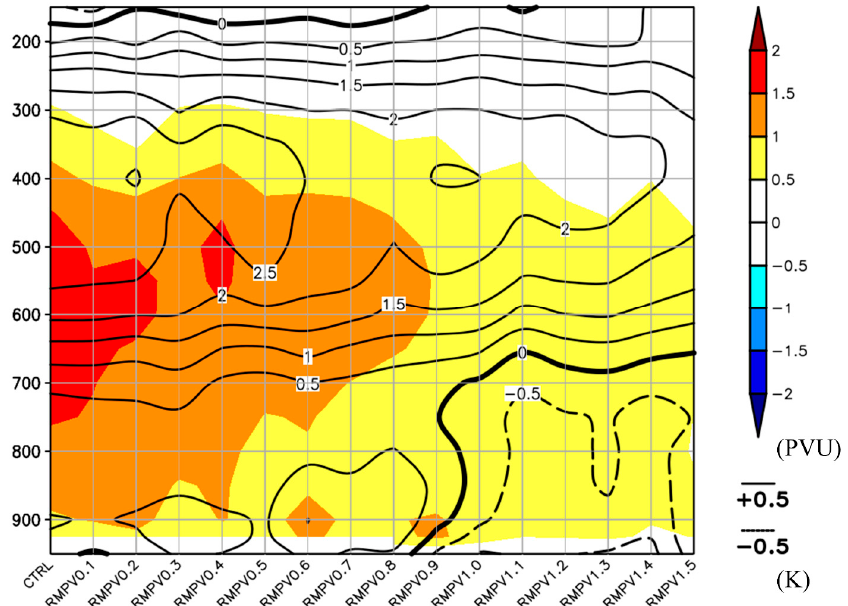
Figure 13. Vertical profile of PV perturbation (shading; PVU) and potential temperature perturbation (contours; K) at 0000 UTC 01 September (+24 h). Both are derived from each experiment averaged over a 1.5 ◦ -radius area centered at 700 hPa vortex center compared to the areal average value over 115 ◦ E to 125 ◦ E, 20 ◦ N to 30 ◦